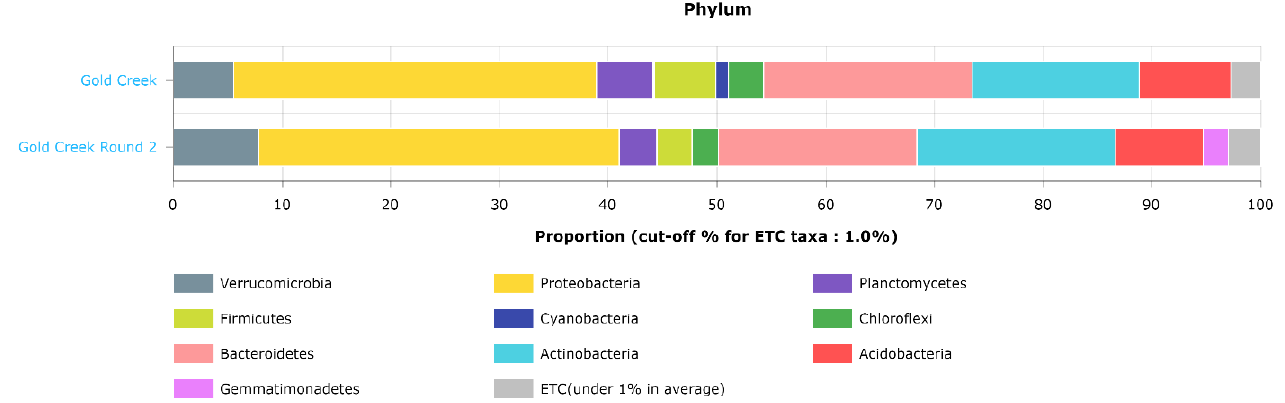
Figure 7. Comparison of the taxonomic composition of the winter sequences versus the summer sequences at the phylum level using EZBioCloud MTP. Table 7. Red Trail vs. Green Trail 16S Round 2 differential abundance analysis (summer). The negative fold change values represent taxa that are elevated on the Green Trail. The positive fold change values represent taxa that were elevated on the Red